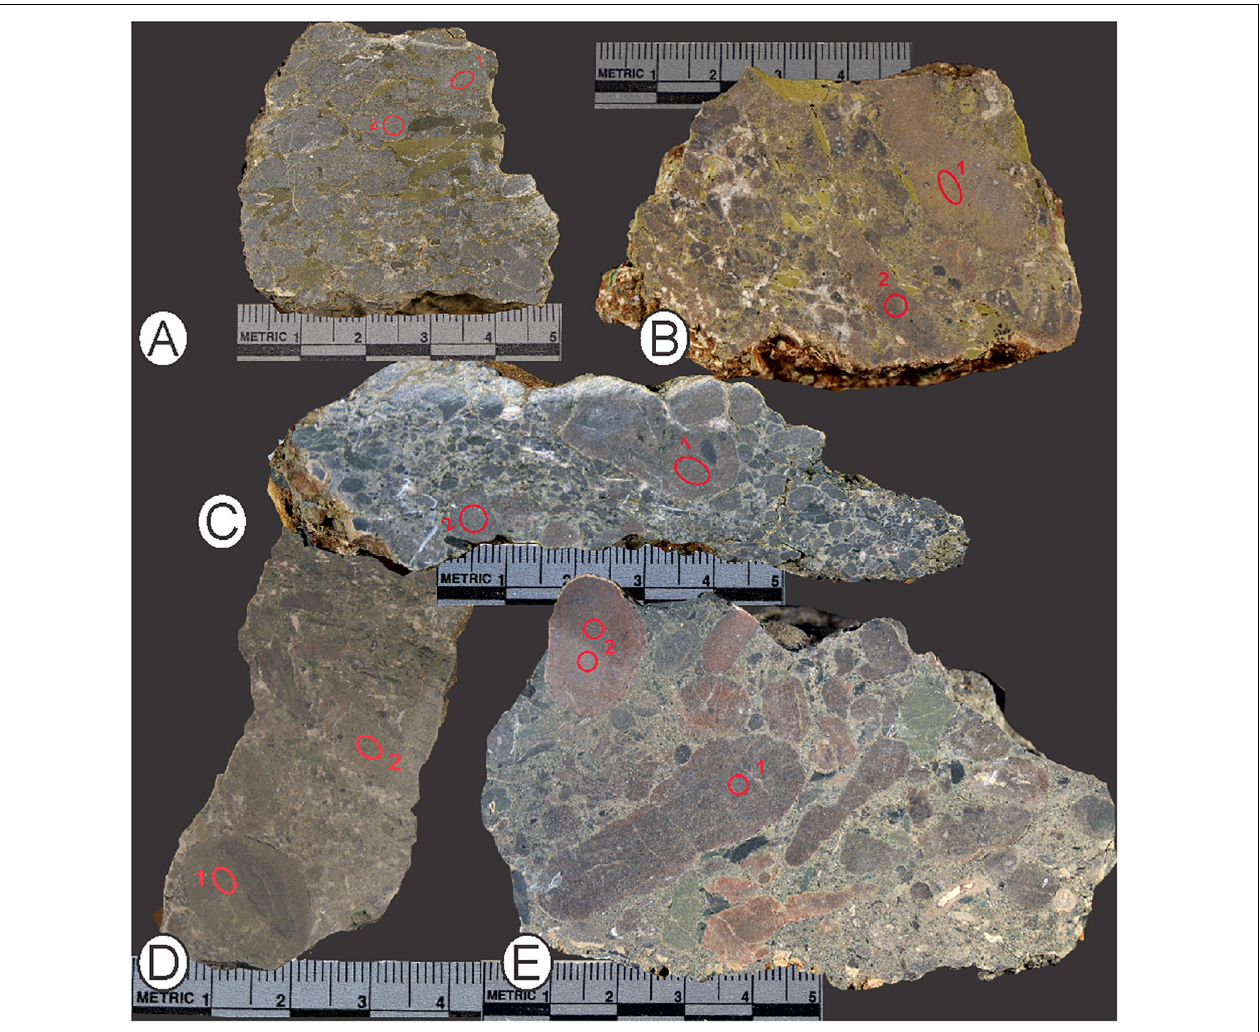
FIGURE 6 | Representative cut-and-sampled PNCs (see Figure 4 for reference). (A) P61 recovered from the uppermost PNC bed at Old Lootsberg Pass. Drilled areas of two nodules are identified. (B) WP843 recovered from the base of Tweefontein 1 . 5 section with sample drill sites indicated. (C) WP857 recovered from the uppermost PNC in the Tweefontein 1 . 5 section; sampled nodules are identified. (D) WP878 recovered from the uppermost PNC lag in a short Tweefontein 2 section where sampled nodules are identified. (E) P51 recovered from the uppermost PNC horizon at Tweefontein 2 . Sites sampled for stable carbon- and oxygen-isotope values are indicated on two nodules. Scales in cm and